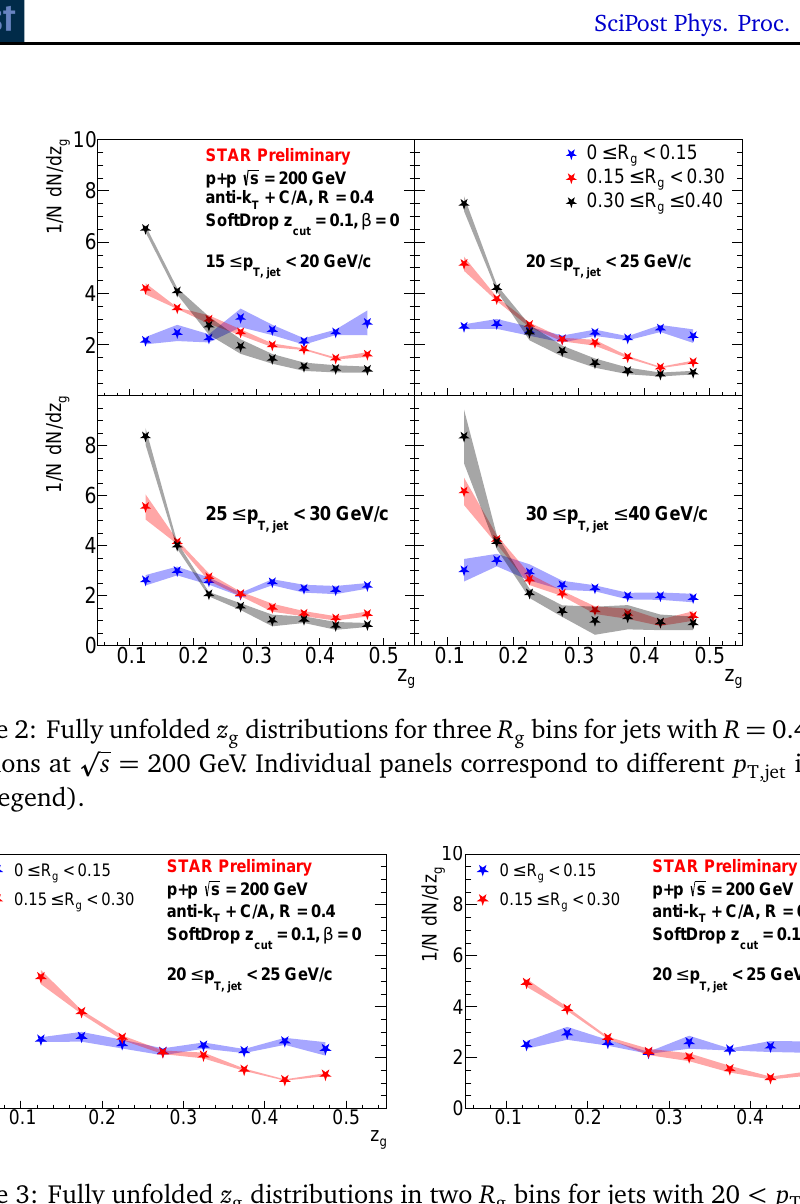
Figure 3: Fully unfolded z GeV / c and R = 0.4 (left) or R = 0.6